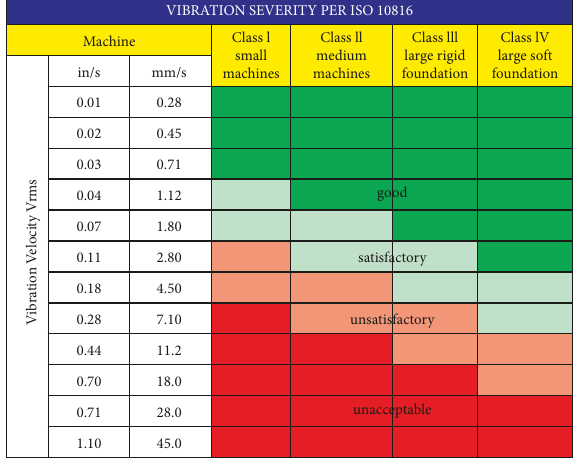
Figure 8: Frequency spectrum of a single-stage gearbox without noise.